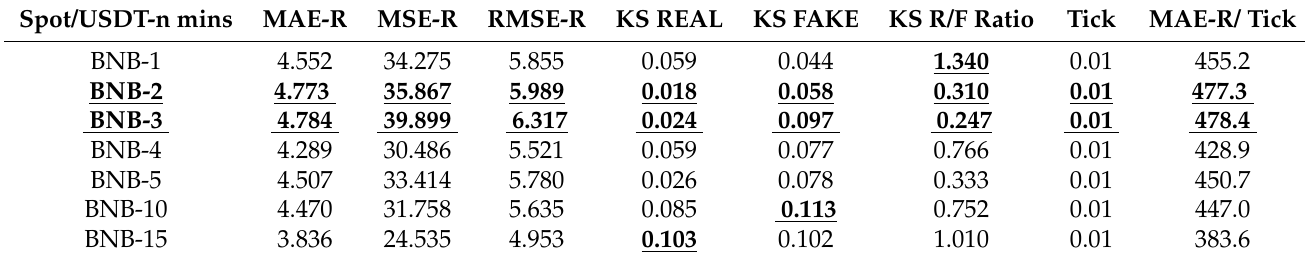
Table 11. We examined BNBUSDT spot prices against generated prices at one, two, three, four, five, ten and fifteen minute intervals. For the KS R/F Ratio, two out of seven are more significant than one, where the highest KS REAL and FAKE are 0.103 and 0.113.